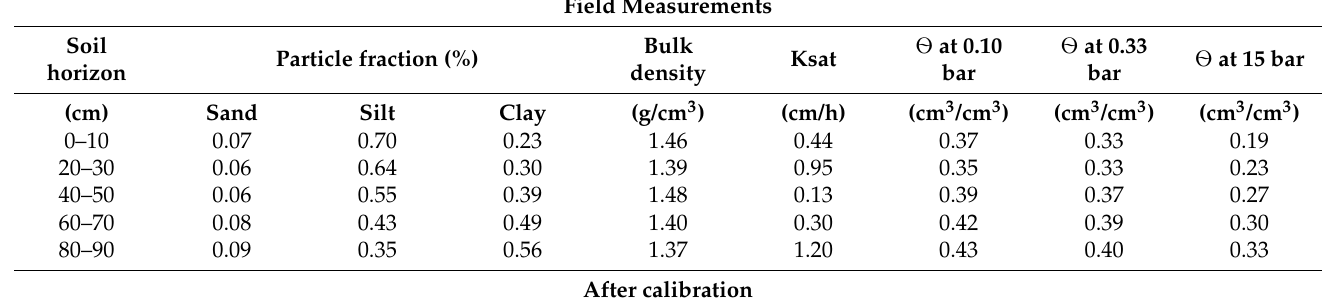
Table 1. Field measurements and model inputs of soil physical and hydraulic properties. Field Measurements